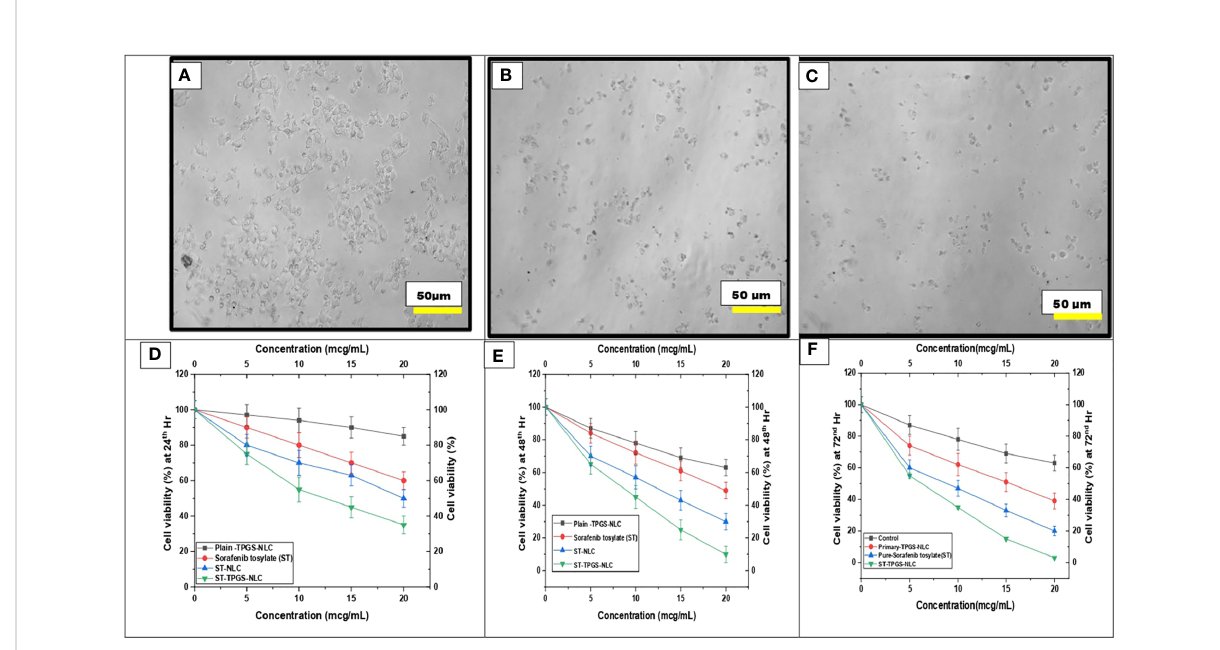
FIGURE 7 Effect of pure ST, Plain/primary-TPGS-NLC, ST-NLC, and ST-TPGS-NLC on cell viability of human female colorectal adenocarcinoma cell lines (SW48 Cells PTEN) using MTT assay treated with different concentrations (0, 5, 10, 15 and 20 m g/mL) after (A, D) 24 hr and (B, E) 48 h. and (C, F) 72 h Data were expressed as the mean ± SD, N =